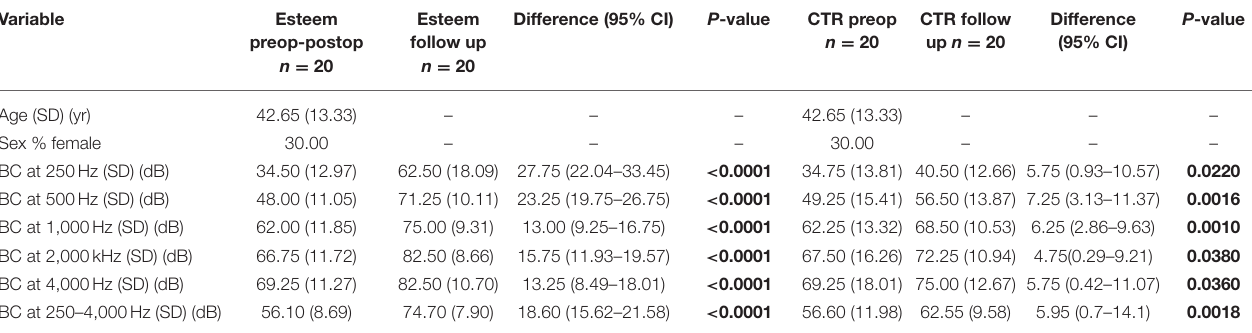
TABLE 1 | Mean (250–4,000Hz) pre-operative and follow-up bone conduction threshold levels in the implanted and contralateral ear.